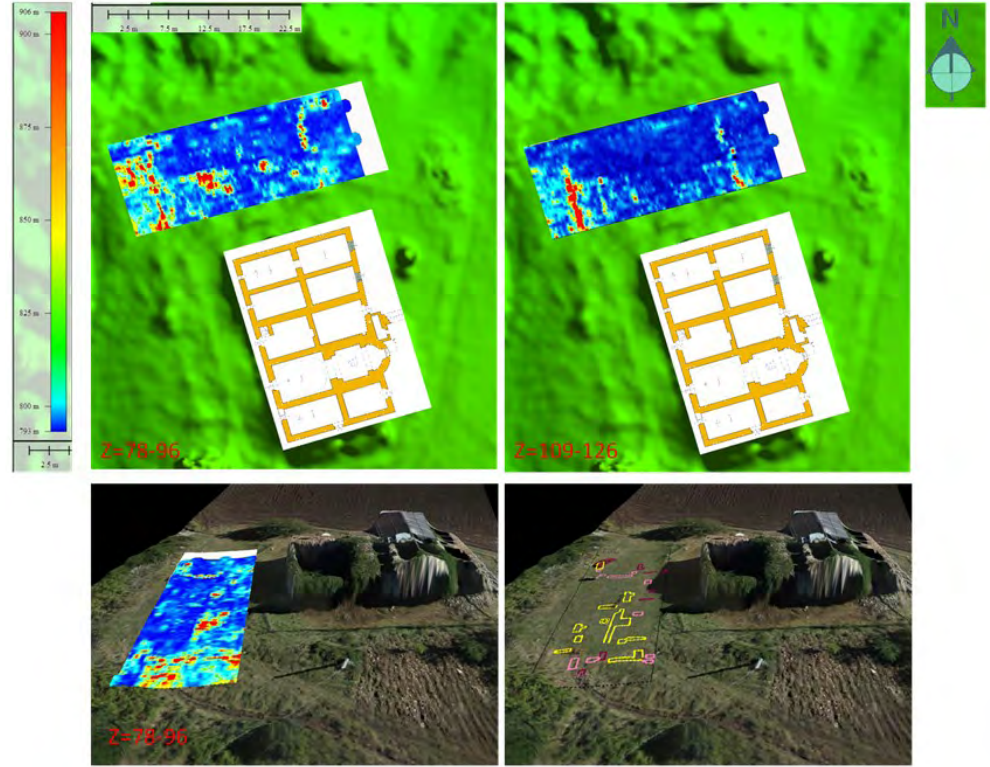
Figure 7. Depth slice overlain on the monastery maps.